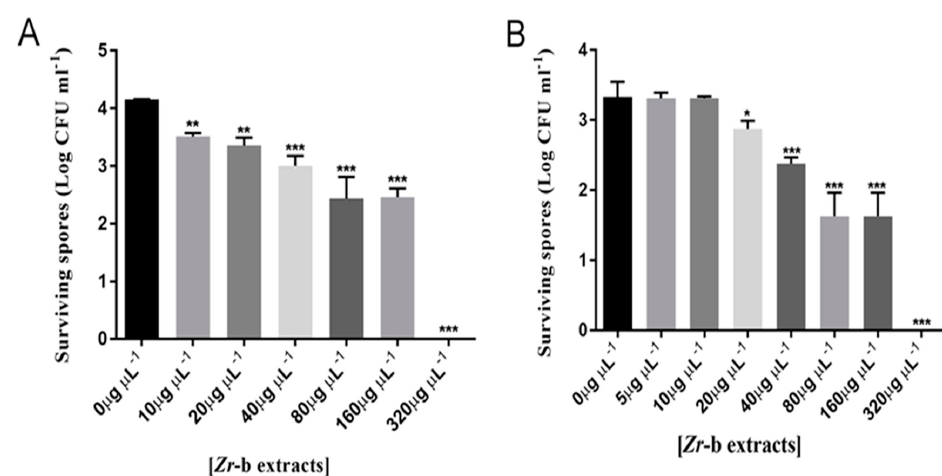
Figure 4. The inhibitory effect of the Zr-b extract on the sporulation of Aphanomyces astaci UEF88662 ( A ) and Fusarium avenaceum SMM2 strains ( B ). The chloroform–methanol (9:1) Zr-b extract concentrations are reported in μ g/ μ L. The experiments were performed in triplicate and statistical significance was examined by the two-way ANOVA test with a Bonferroni correction. Values for surviving spores are reported as mean ± SDs. Asterisks indicate statistical significance (* p < 0.05; ** p < 0.001; *** p < 0.0001).